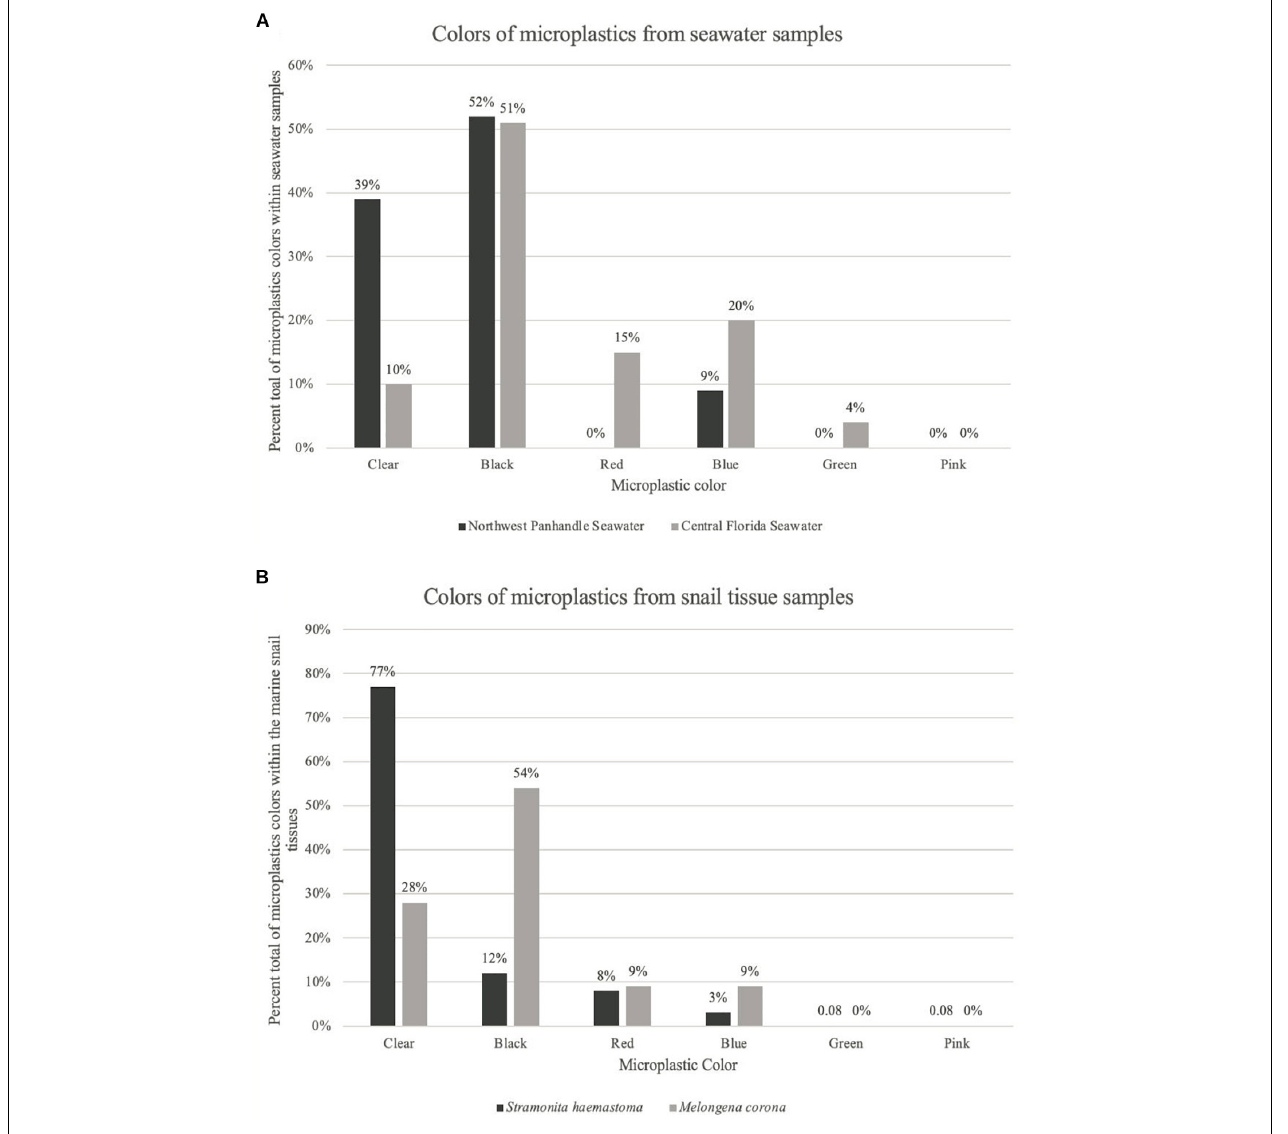
FIGURE 2 | Graph of color distribution of microplastics from seawater samples and snail tissue samples. (A) Shows the percent of each color of microplastics from seawater samples. Dark gray bars correspond to seawater microplastics from Northwest Panhandle Florida and light gray bars correspond to seawater microplastics from Central Florida. (B) Shows the percent of each color of microplastics from snail tissue samples. Dark gray bars correspond to snail tissue microplastics from Northwest Panhandle Florida and light gray bars correspond to snail tissue microplastics from Central Florida.